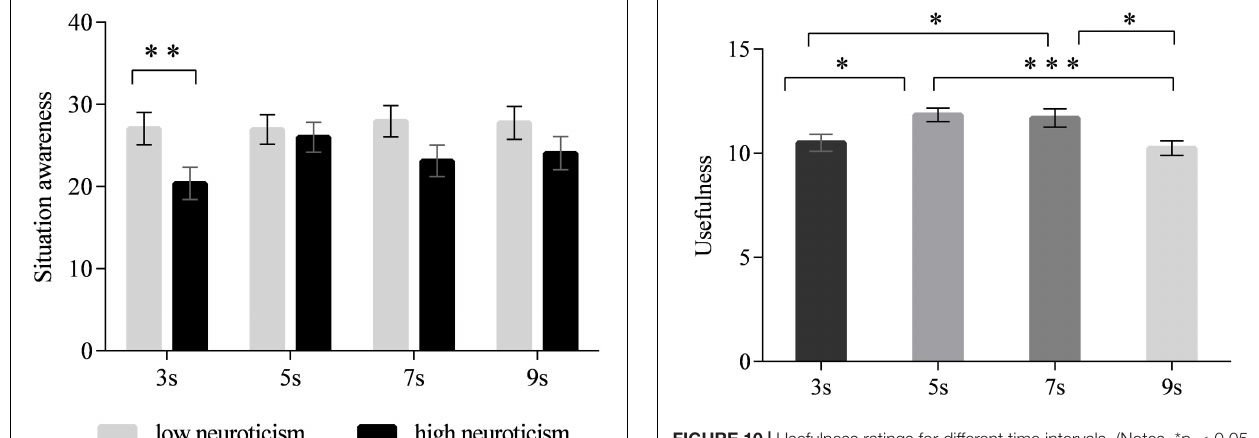
FIGURE 10 | Usefulness ratings for different time intervals. (Notes. * p < 0.05, *** p <